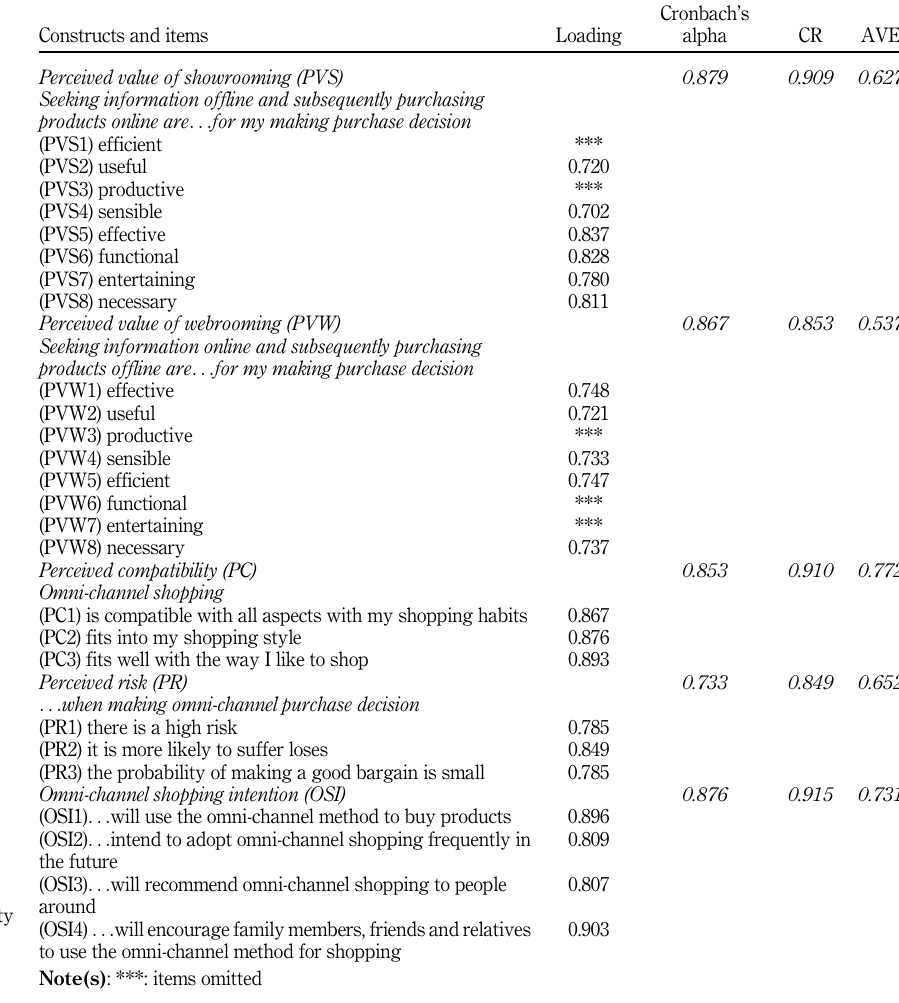
Table 2. The results of assessing the validity and reliability of research ’ s